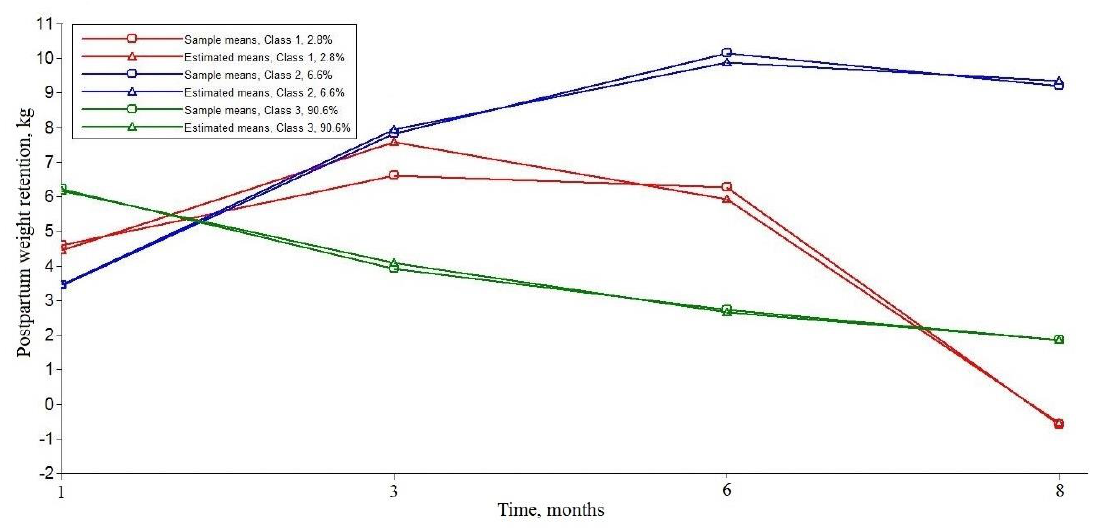
Figure 1. Three distinct latent trajectories of postpartum weight retention.